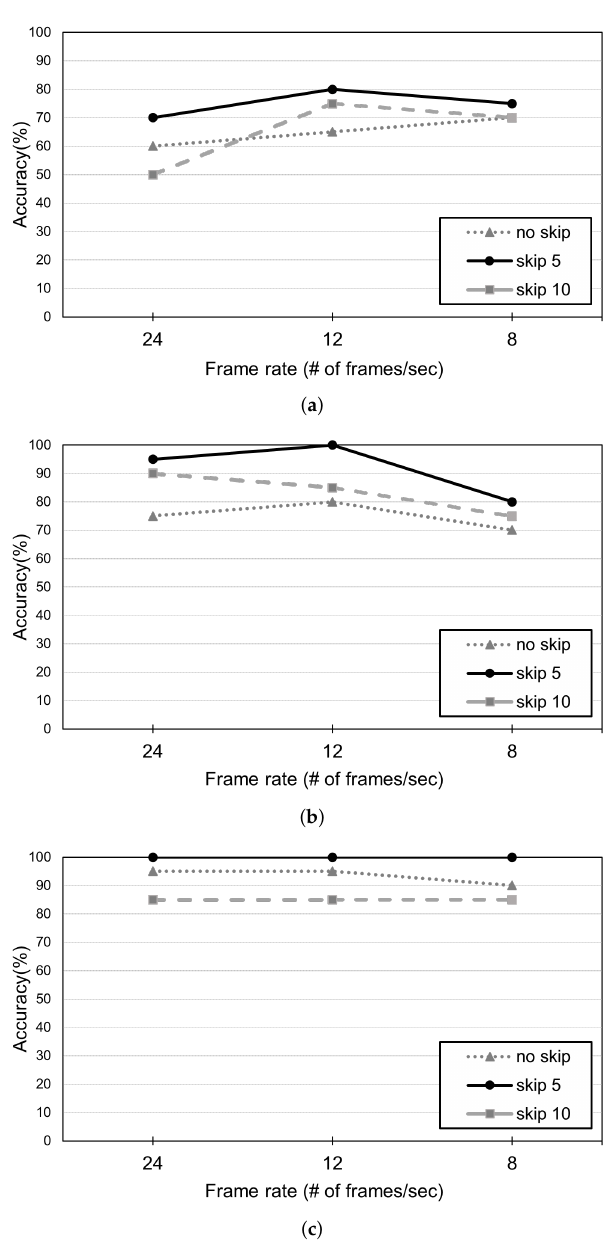
Figure 9. Effect of frame sampling rate for three movement features: ( a ) vector, ( b ) unit vector and ( c )